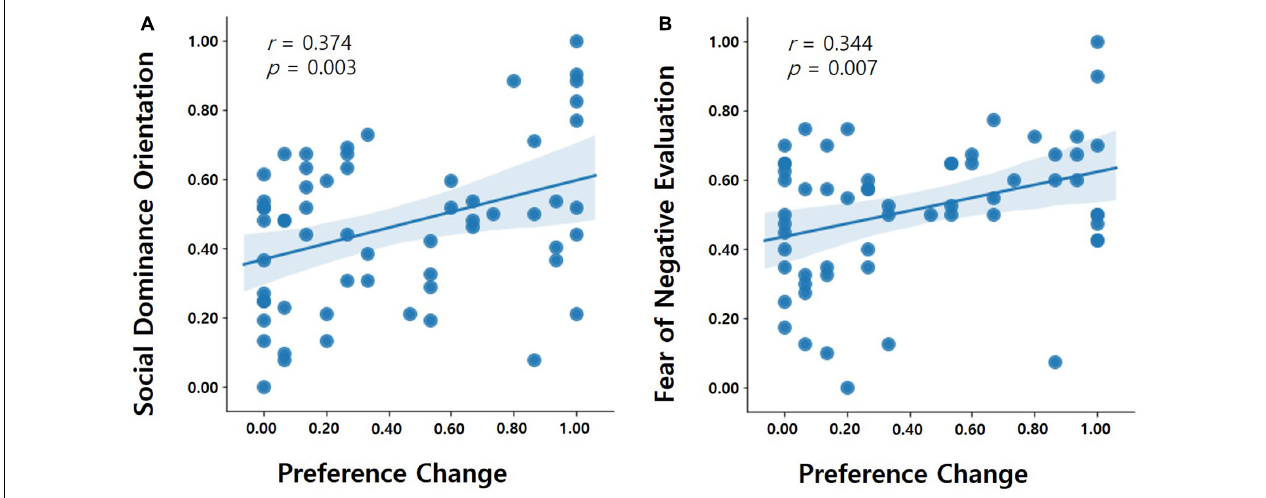
FIGURE 4 | Individual differences predicting the degree of social conformity. The degree to which participants changed their preferences in incongruent trials due to social hierarchy under the public condition were predicted by individual differences in (A) the normalized SDO scores ( r = 0.37; p = 0.003, two-tailed Pearson correlation) as well as by (B) the normalized FNE scores ( r = 0.34; p = 0.007, two-tailed Pearson correlation).